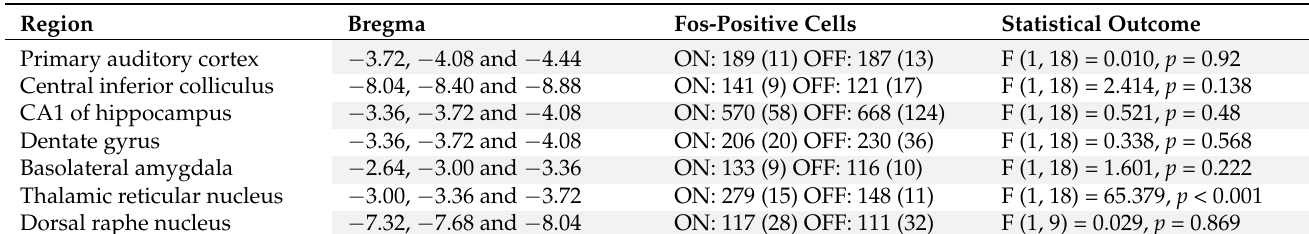
Table 3. C-Fos results of the measured regions in ON vs. OFF status of